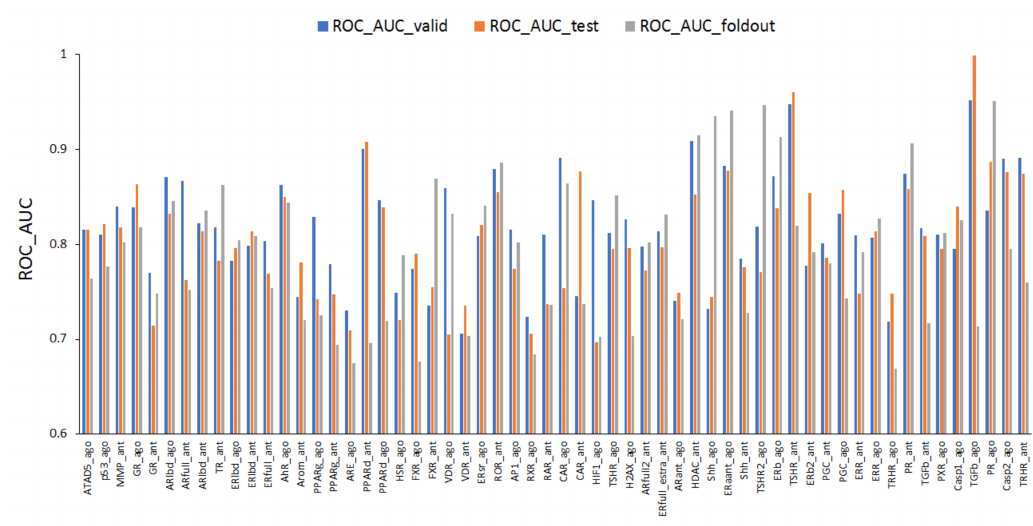
Figure 1. Area under the receiver operating characteristic curve (ROC_AUC) for 59 key molecules in MIEs on the validation, test, and foldout datasets. The model exhibiting the highest prediction performance was selected out of six angles in DeepSnap-DL.